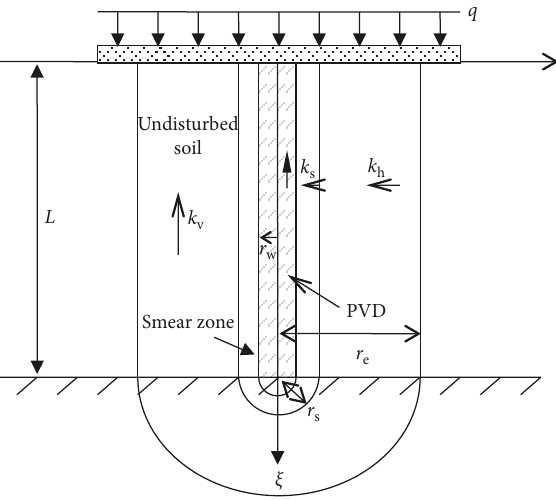
Figure 1: Schematic diagram of the typical cylindrical cell.